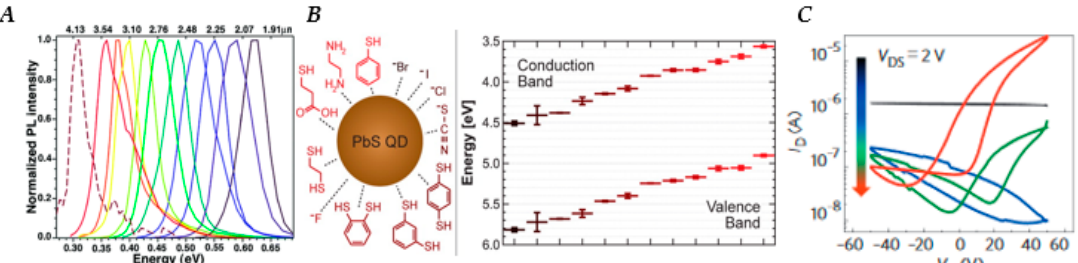
Figure 1. ( A ) Normalized photoluminescence spectra of lead selenide (PbSe) quantum dots (QDs) of varying sizes, as an indication of bandgap tenability (bottom x-axis has units of energy (eV) ranging from 0.30 to 0.65 eV, top x-axis has units of wavelength ranging from 4.13 to 1.91 µm). Reproduced with permission from [13]. Copyright American Chemical Society, 2004. ( B ) Illustration of a lead sulfide (PbS) QD with various types of ligands (left), and the corresponding (by color) conduction and valence band energy levels each ligand produces (right). The positions of the valence and conduction bands of PbS QDs with different ligands are presented in the graph to the right. Beginning with Br - (brown color, lowest band positions) moving clockwise around the schematic of the QD until it reaches benzenethiol (red color, highest band positions). Reproduced with permission from [18]. Copyright American Chemical Society, 2014. ( C ) Transfer characteristics of a 5.9 nm PbSe QD film after solid-state exchange with sodium selenide (Na 2 Se) (black), which removes long oleate ligands and enriches the surface in Se, and subsequently upon lead chloride (PbCl 2 ) treatment for durations of 1 h (blue), 6 h (green) and 12 h (red) at 65 °C, which enriches the surface in metal. I D , drain current; V G , gate voltage; V DS , drain–source voltage. Reproduced with permission from [64]. Copyright American Chemical Society, 2014.